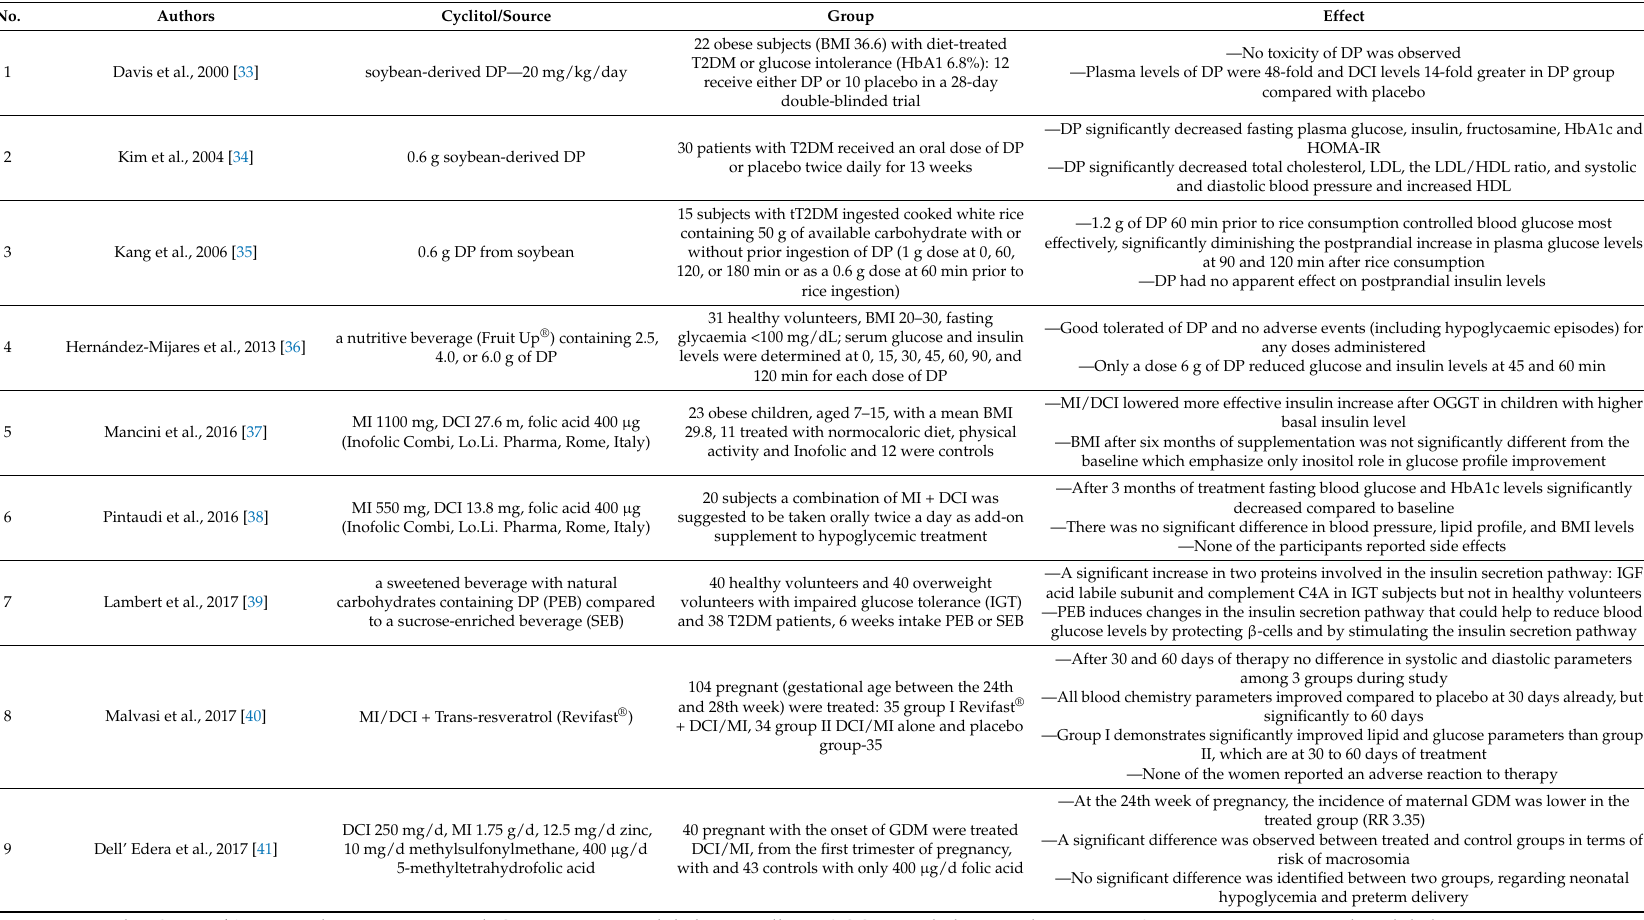
Table 2. The effect of cyclitols on humans’